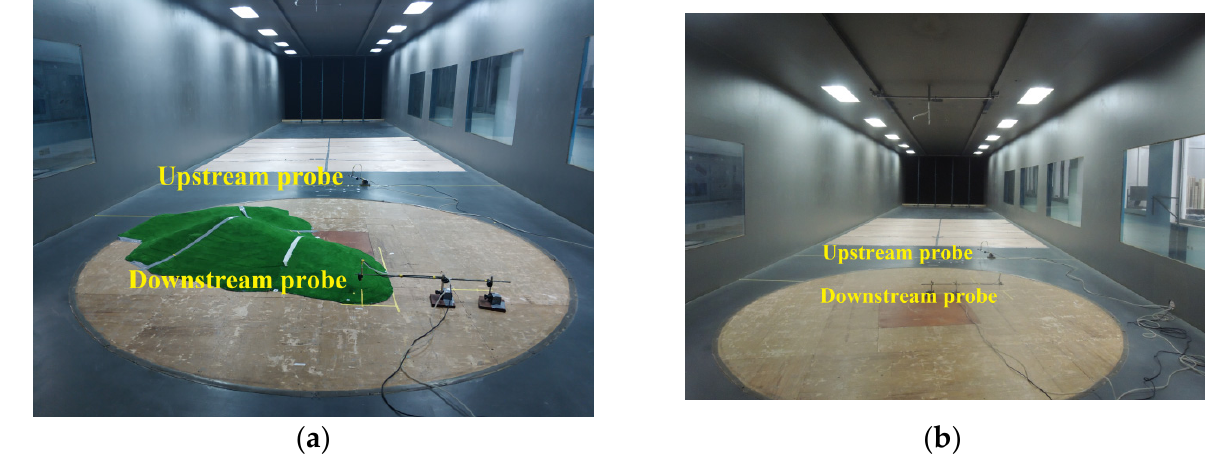
Figure 4. WTT model of Noi Ling Ding Island: ( a ) with NLDI; ( b ) without NLDI.